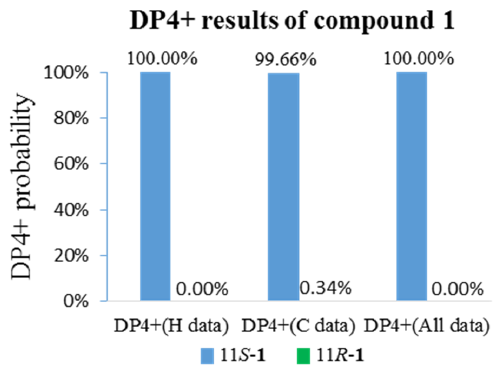
Figure 3. Key ROESY correlations of compounds 1 and 4 .